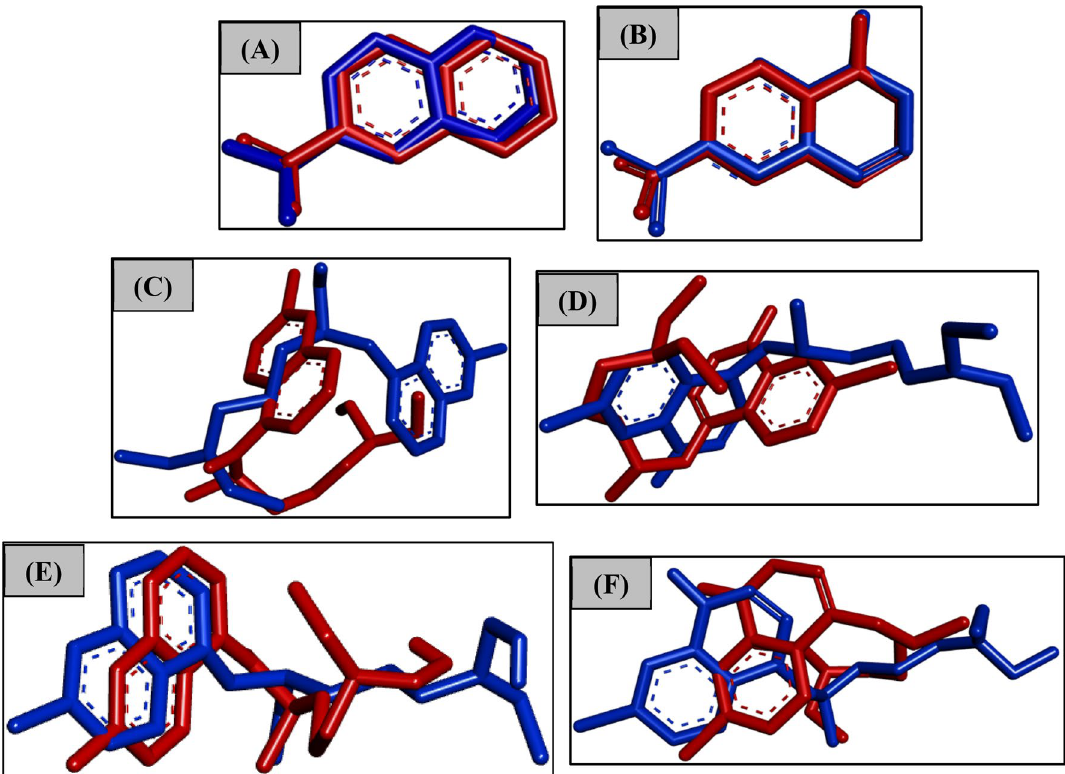
Figure 4. Overlap of the initial (red) and representative (blue) structures of the 20-ns simulation of MD. Image generated in the Discovery Studio Software 4.5 https:// disco ver. 3ds. com/ disco very- studio- visua lizer- downl